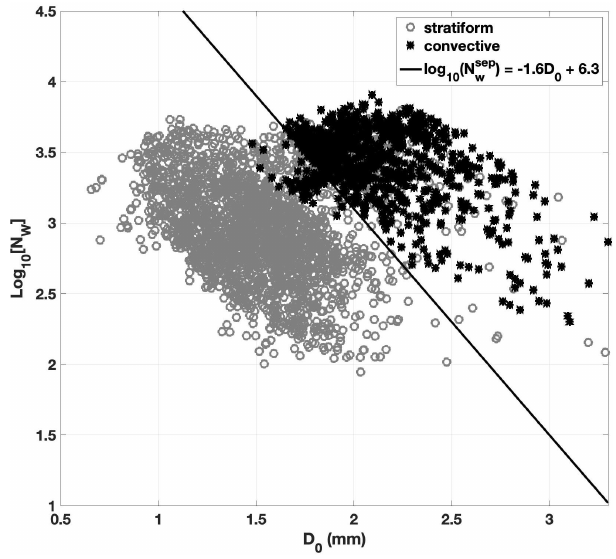
Figure 3. The distribution of log10 (N w ) vs. D 0 . The DSD data from stratiform and convective precipitation are presented with gray circles and black stars, and the separator line is shown with a solid